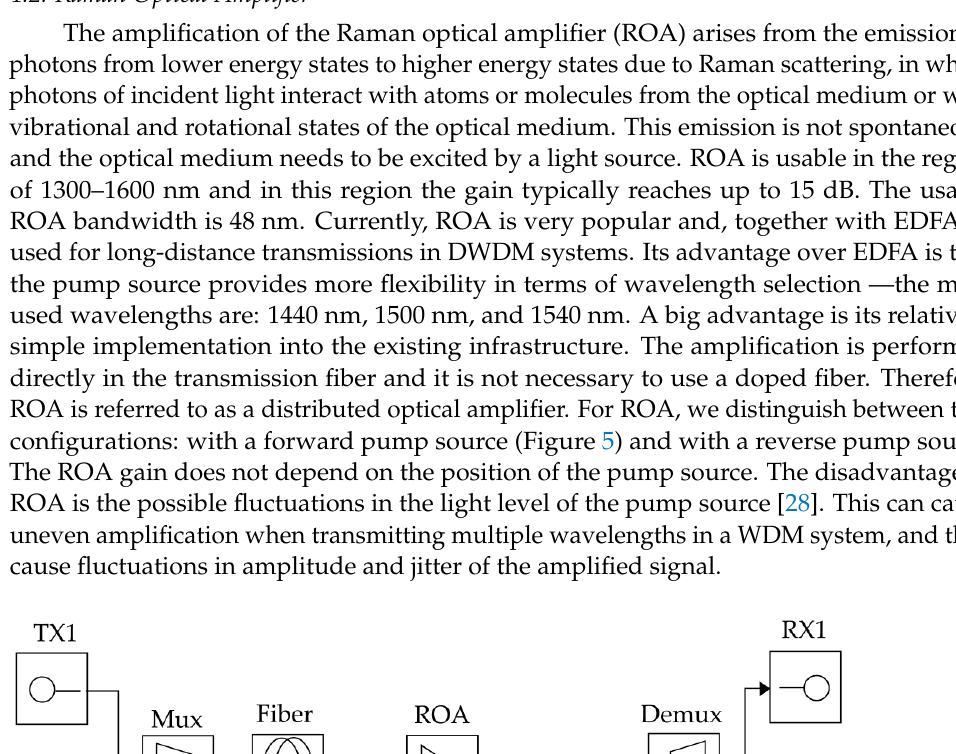
Figure 4. Optical spectrums for the first and twentieth channels EDFA.